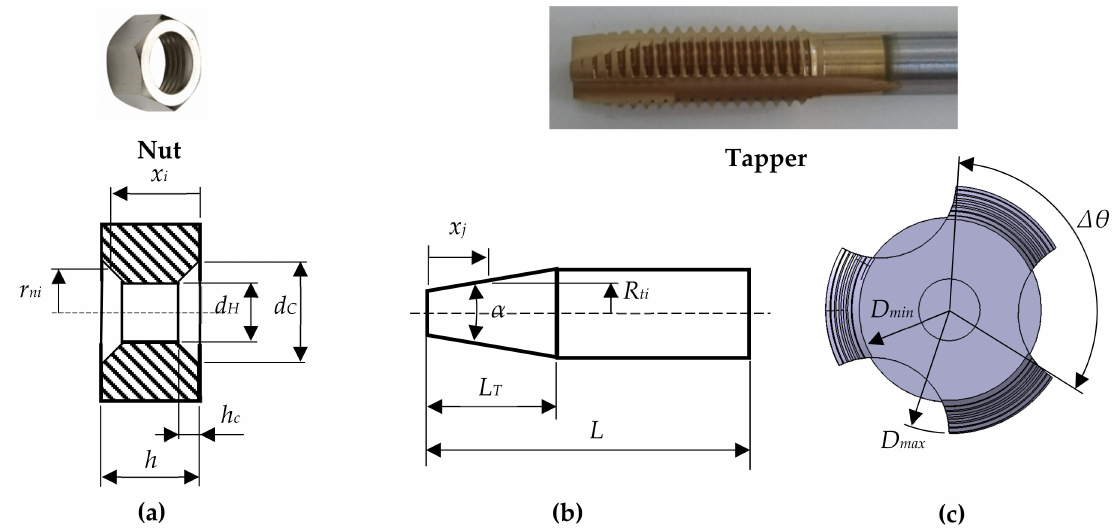
Figure 3. Parameters: ( a ) nut; ( b ) side view of tapper; ( c ) front view of tapper.